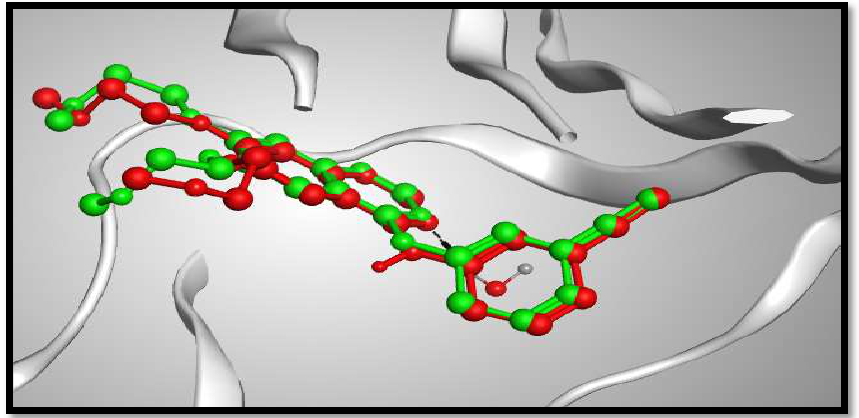
Figure 5. 3D representation of the superimposition of the co-crystallized ligand (purple) and the docking pose (dark grey) of ERL at the active site of the EGFR enzyme.